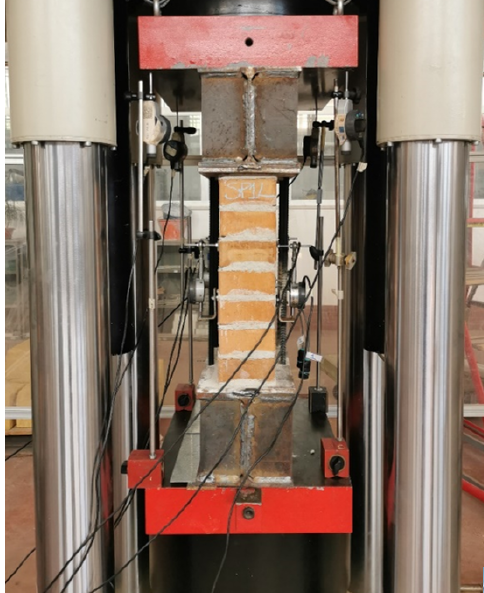
Figure 8. Test setup.